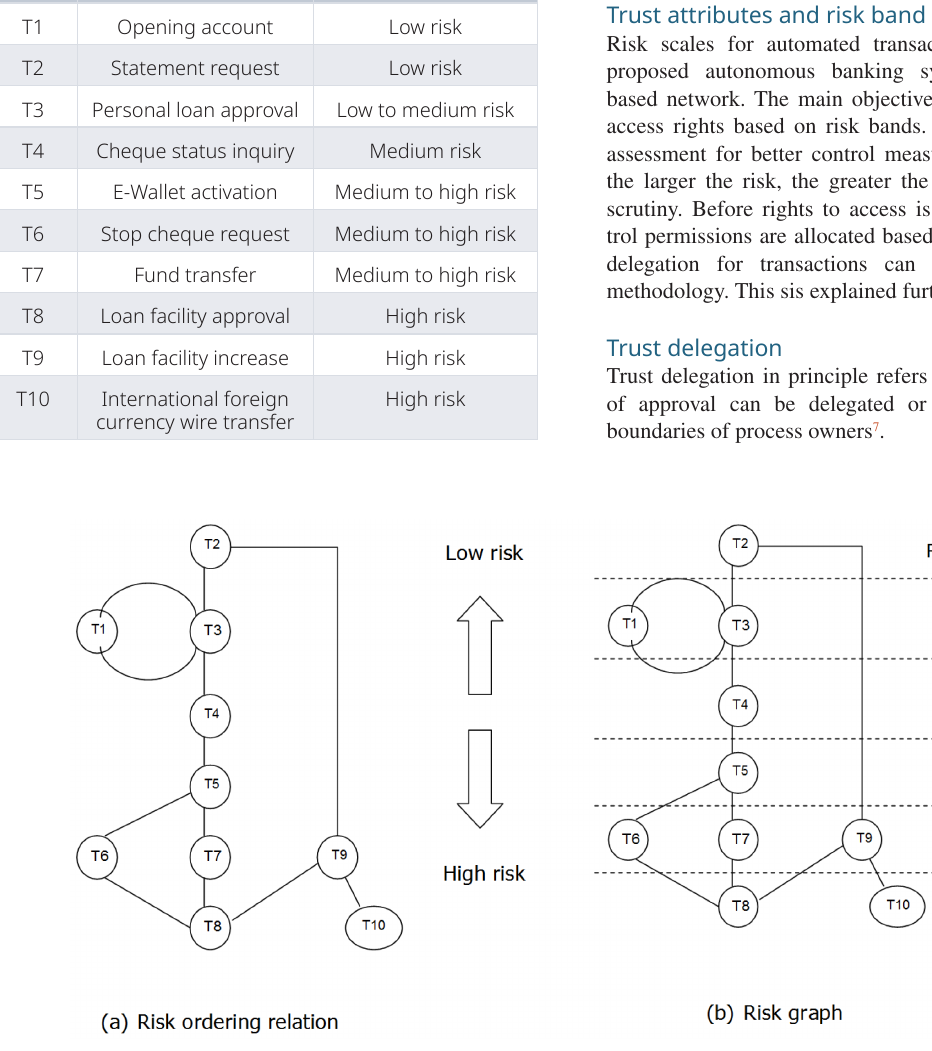
Figure 4. Risk Graph associated with Risk Band